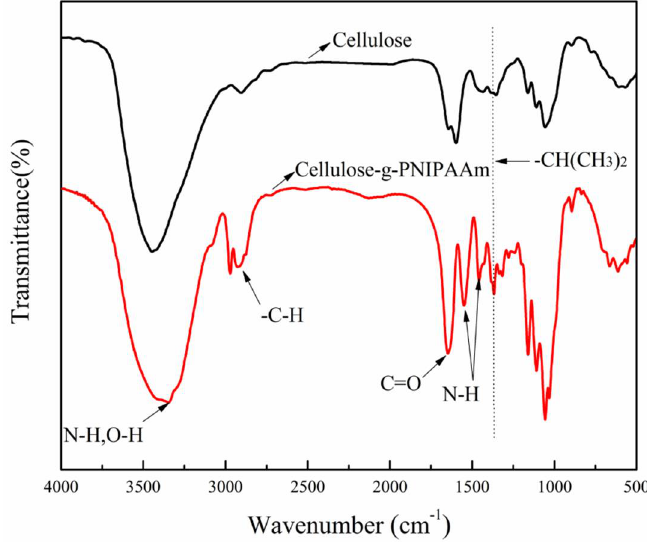
Figure 2. The Fourier Transform Infrared spectroscopy spectra of the cellulose and cellulose- g -PNIPAAm.